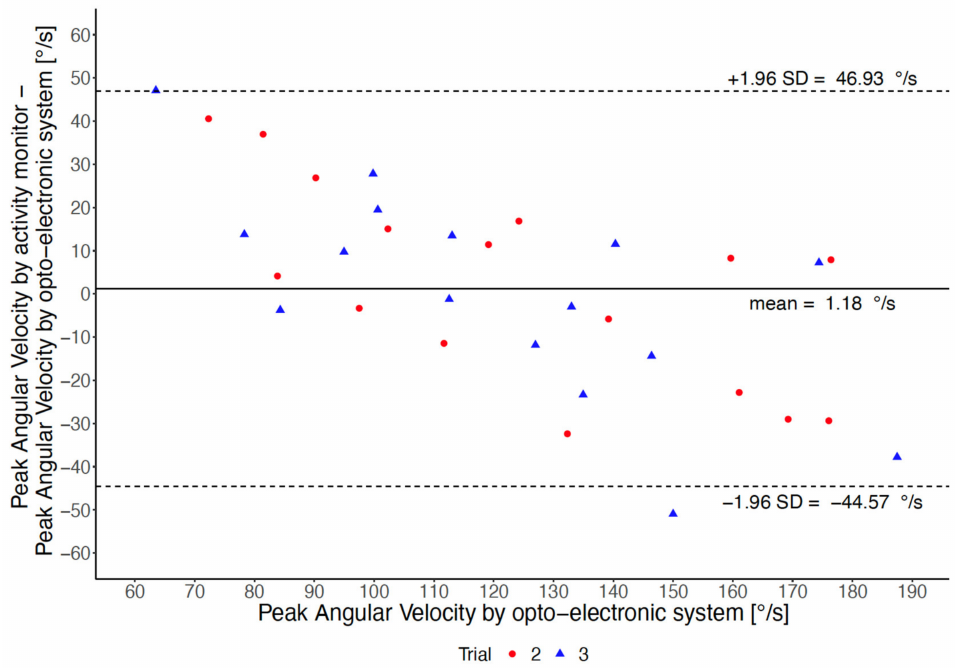
Figure 2. Agreement of peak angular velocity measured by the thigh-worn activity monitor with peak angular velocity measured by the opto-electronic system, according to Trials 2 and 3. The typical error of PAV measured by the activity monitor was 15.3 (95% CI: 11.7; 22.4) ◦ /s, while the SWC 0.2 was 5.3 ◦ /s, and the SWC 0.6 was 16.0 ◦ /s. The Intra-Class